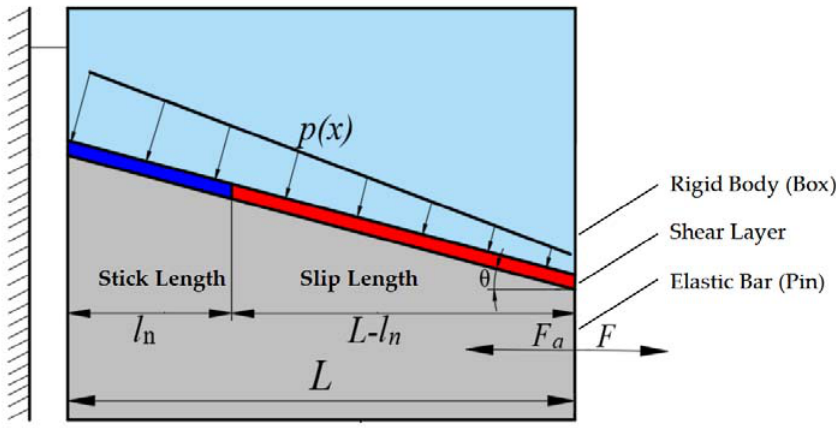
Figure 4. Shear layer model of the sealing face of the premium connection. The properties of the shear layer are similar to the ideal elastic–plastic